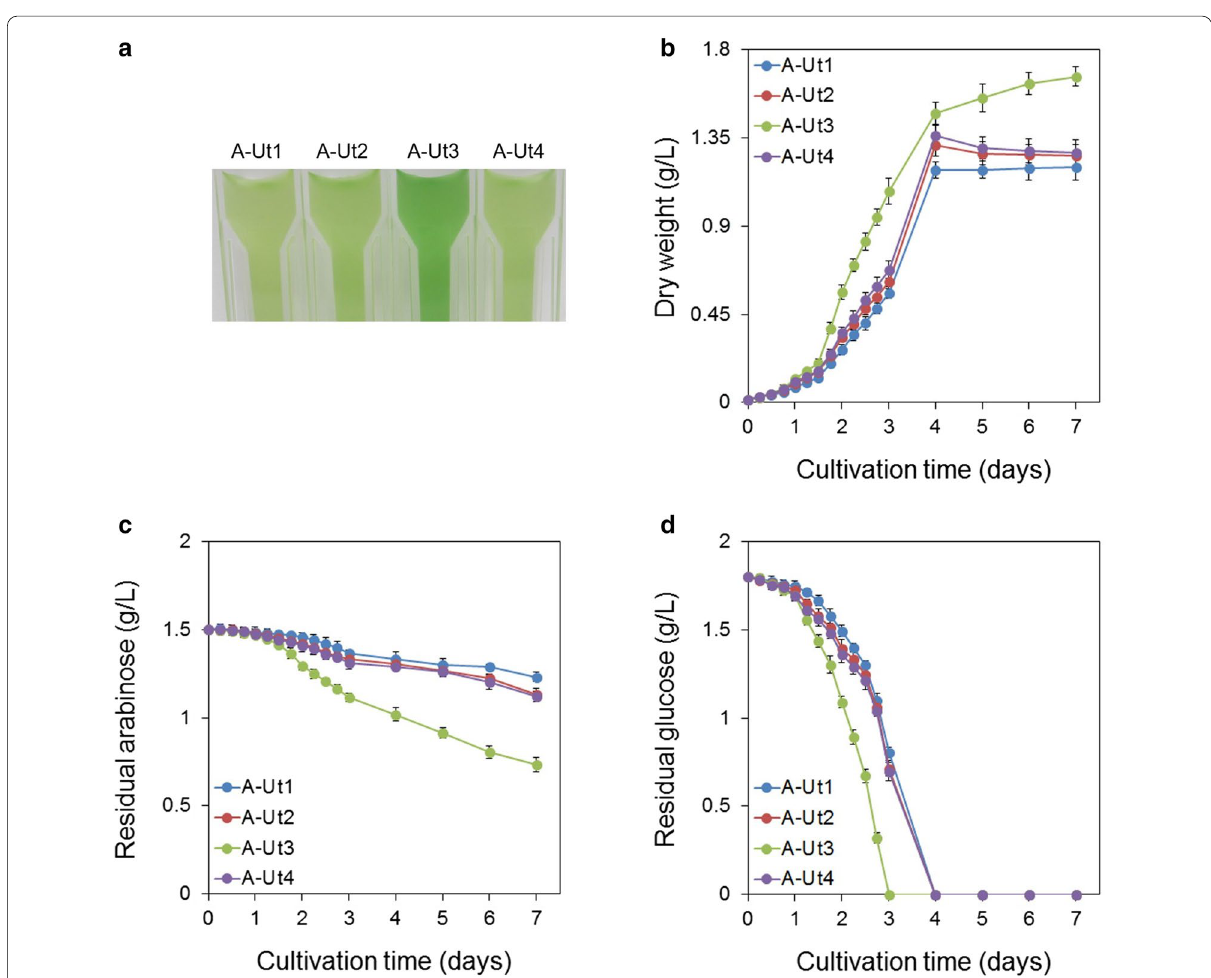
Fig. 5 Growth and sugar consumption in the presence of 10 mM arabinose and glucose. Synechocystis strains A-Ut1, A-Ut2, A-Ut3 and A-Ut4 were grown in the presence of 10 mM (1.50 g/L) L-arabinose and 10 mM (1.80 g/L) D-glucose. a Photograph depicting differential growth shown by the transformant strains at the end of the third day of culture. b Dry biomass, c Residual arabinose and d Residual glucose measured in the cultures of the transformant strains. Data represented in graphs were collected from three biological replicates and presented as means